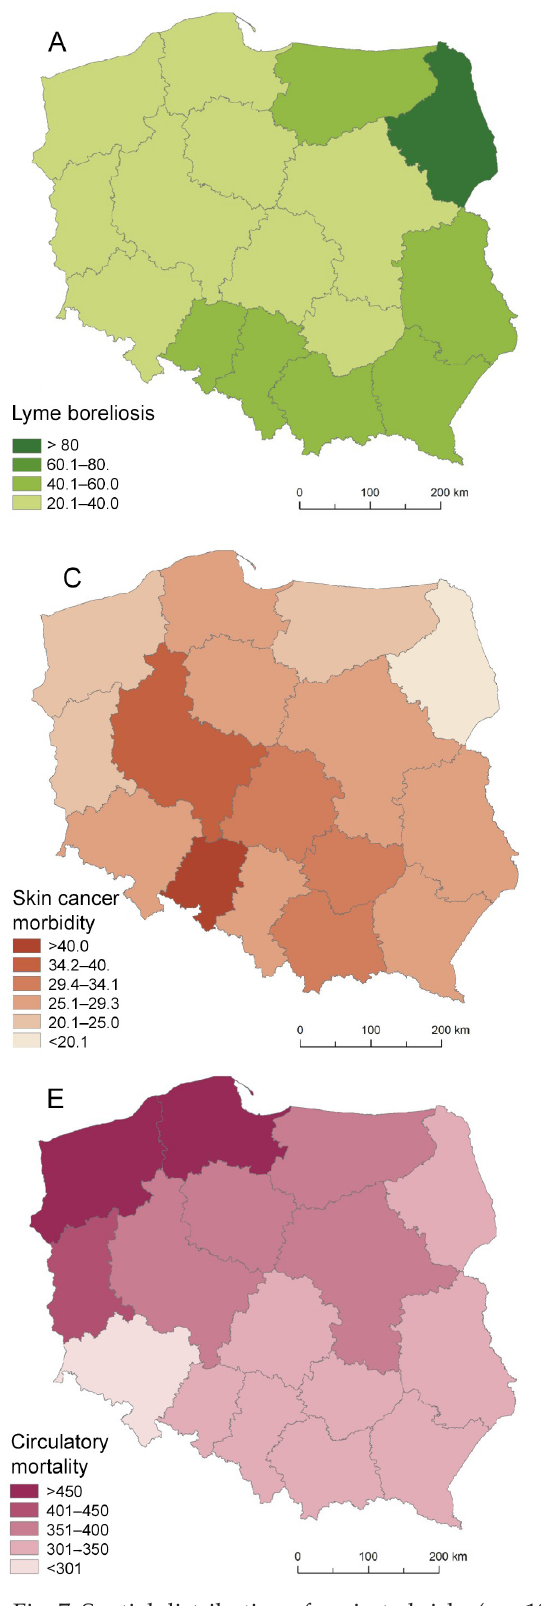
Fig. 7. Spatial distribution of projected risks (per 100 000 inhabitants) of selected CRD at the last decade of 21 st century due to A1B SRES scenario, A – Lyme boreliosis, B – influenza, C – skin cancer morbidity, D – skin cancer mortality, E – circulatory mortality, F – respiratory